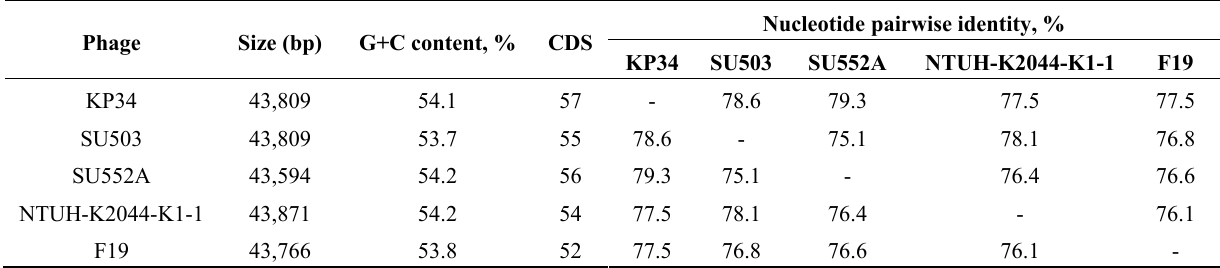
Table 2. Genome information and pairwise identity of the members of “Kp34likevirus”.